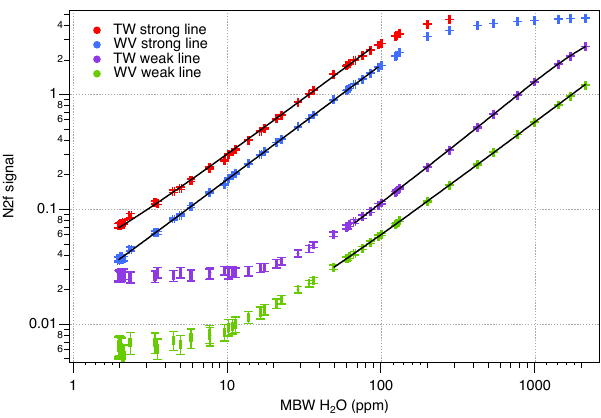
Figure 8. Laboratory calibration curves showing the laser power normalized second harmonic (N2f) signals from the strong and weak absorption lines (2693.82 and 2694.06nm, respectively) in the WV and TW channels as a function of the H 2 O mixing ratio in the sample flow measured by the MBW reference hygrometer. Each data point represents an average of 100–300s of data at a constant mixing ratio. The error bars are the standard deviation of the N2f signal in each interval. The black lines are the weighted orthogonal linear regression fits to the data, which are used to determine in- strument sensitivity for each absorption line. The differences in N2f values between channels at the same MBW value are due to intrinsic performance and configuration differences between the channels.